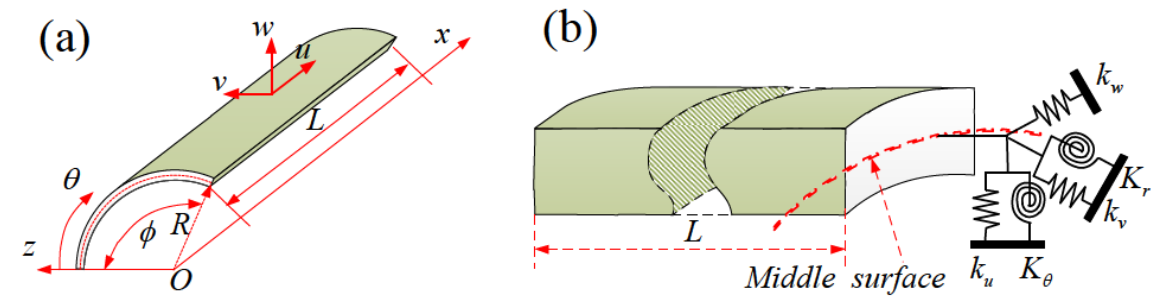
Figure 1: Geometry properties of FG-CNT reinforced composite cylindrical